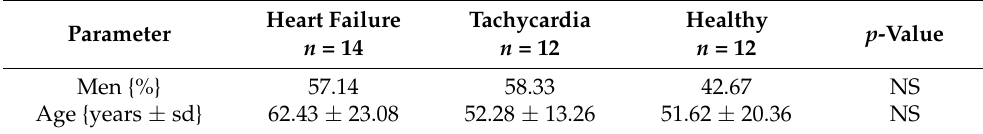
Table 3. Demographic characteristics of the examined individuals.